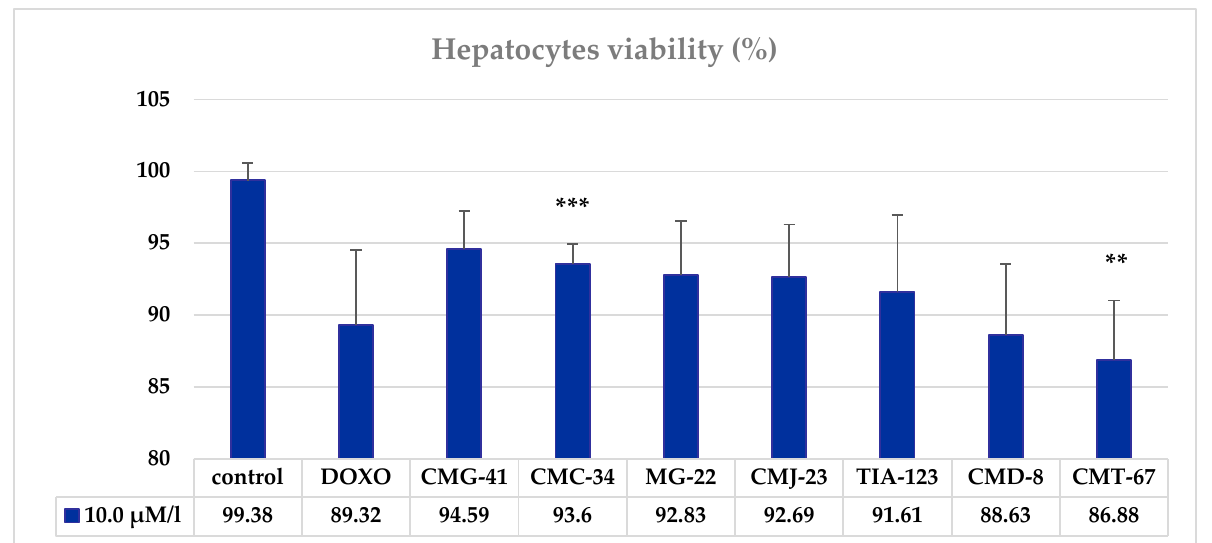
Figure 2. Influence of thiosemicarbazide coordination compounds at doses of 10.0 μ M/L on Wistar rats’ hepatocytes’ viability tested in vitro by MTT assay. Note: statistical significance in comparison with the control—** — p < 0.01; *** — p < 0.001.